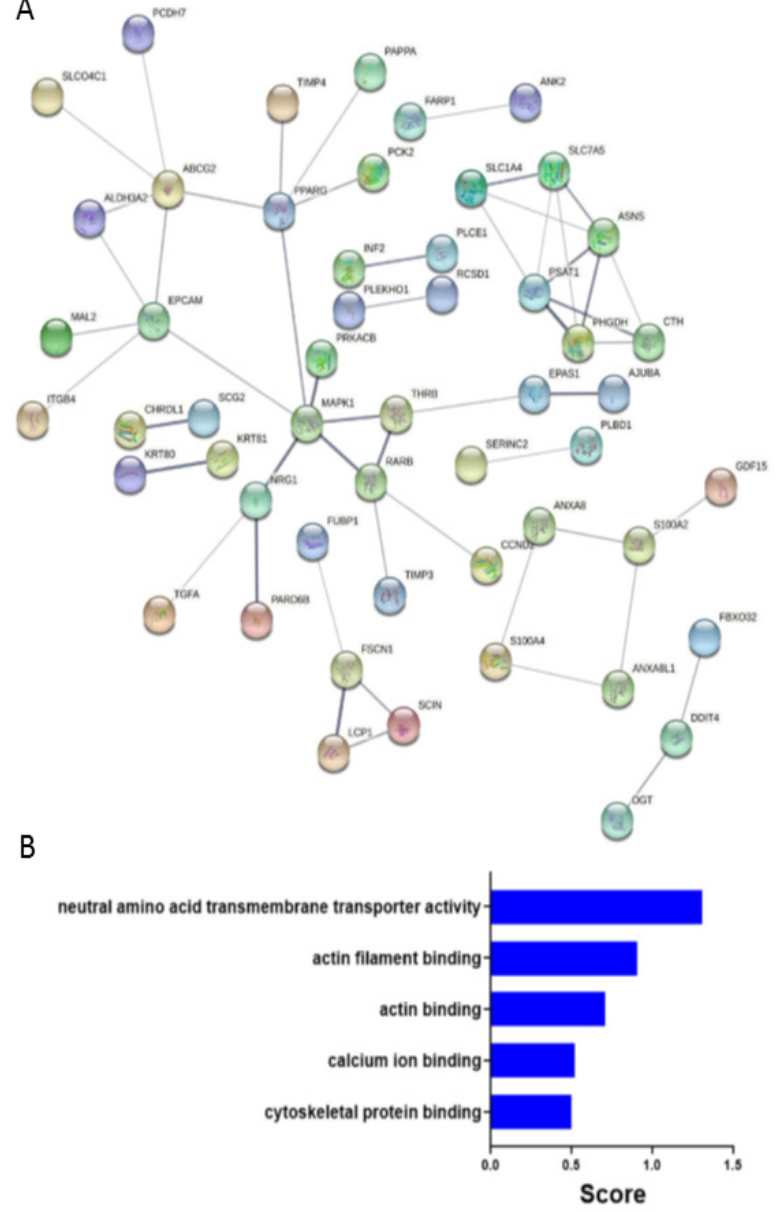
Figure 6. Protein-protein interaction network and gene ontology (GO) enrichment. ( A ) Constructed protein-protein interaction network of 93 downregulated genes in FSCN1 KD compared to FSCN1 CON MDA-MB-231 cells. Nodes represent proteins and different line intensities denote the type of evidence for the interaction. Statistical analysis results for the network: number of nodes: 88, number of edges: 49; average node degree: 1.1; average local clustering coefficient: 0.44; expected number of edges: 31; PPI enrichment p -value =0.001. ( B ) GO enrichment bar chart of downregulated genes in FSCN1 KD compared to FSCN1 CON MDA-MB-231 cells showing most enriched GO terms.